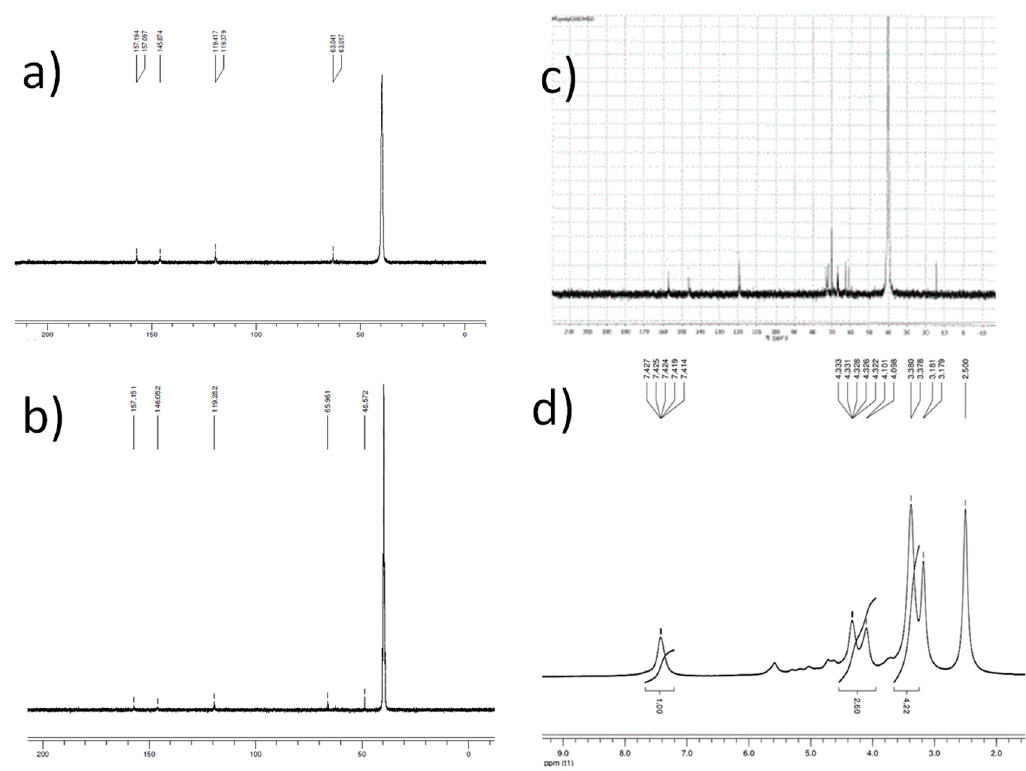
Figure 1. ( a ) 13 C-NMR spectrum of PEF in DMSO- d 6 ; ( b , d ) 13 C- and 1 H-NMR spectra of PHPF in DMSO- d 6 and ( c ) 13 C-NMR of PDGF measured in DMSO- d 6 .